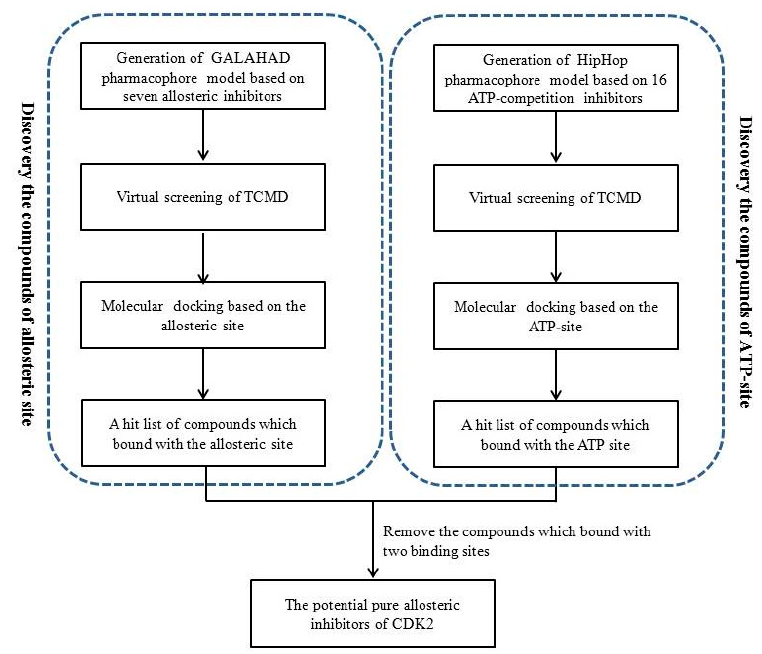
Figure 1. Virtual screening strategy of this study.